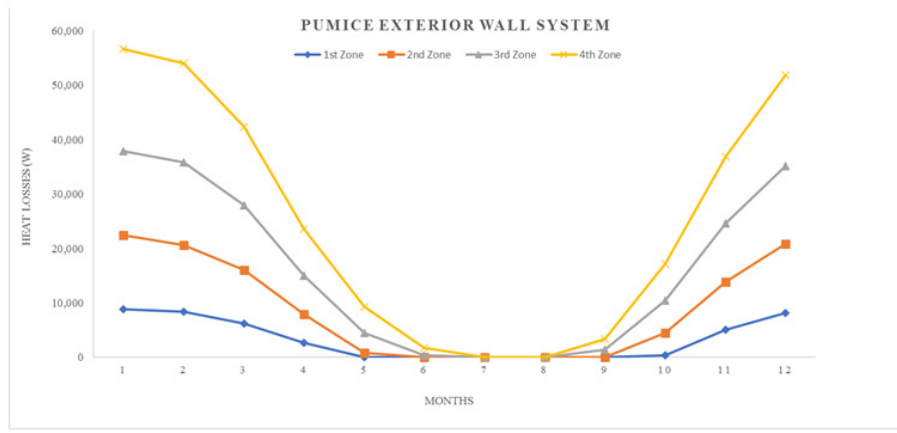
Figure 13 . Heating energy demand for pumice exterior wall system . As it is understandable from the figures, the heat demand in the four different degree day regions decreases towards summertime months, thus the heat loss decreases in proportion to the summer months on aforesaid dates. At the beginning of the subject, since the annual heat requirement values of the building materials are optimized by calculations and this value is kept constant and equal, the heat demand and heat losses of the materials are approximately the same in the graphics. Climatically, the 1st degree day zone is the lowest in terms of heating need and the highest in terms of cooling need. For this reason, Erzurum province, selected in the study, gives the highest heat demand and heat loss among other provinces (Antalya, İ stanbul and Ankara). In areas with a high cooling load, proper insulation will provide long-term economy and comfort in the structure in terms of the operating period. 3.2. Condensation and Evaporation Amounts in Building Elements In buildings that are situated in countries where external ambient temperatures vary in a wide range, such as Turkey, the importance of material insulation applications are increasing day by day in order to bring down the heat losses in winter months and the heat gains in summer months. The condensation that occurs as an outcome of water vapor diffusion negatively affects the heat transfer occurring in building materials Condensation or perspiration on surfaces that occur in building materials, especially in cold seasons,